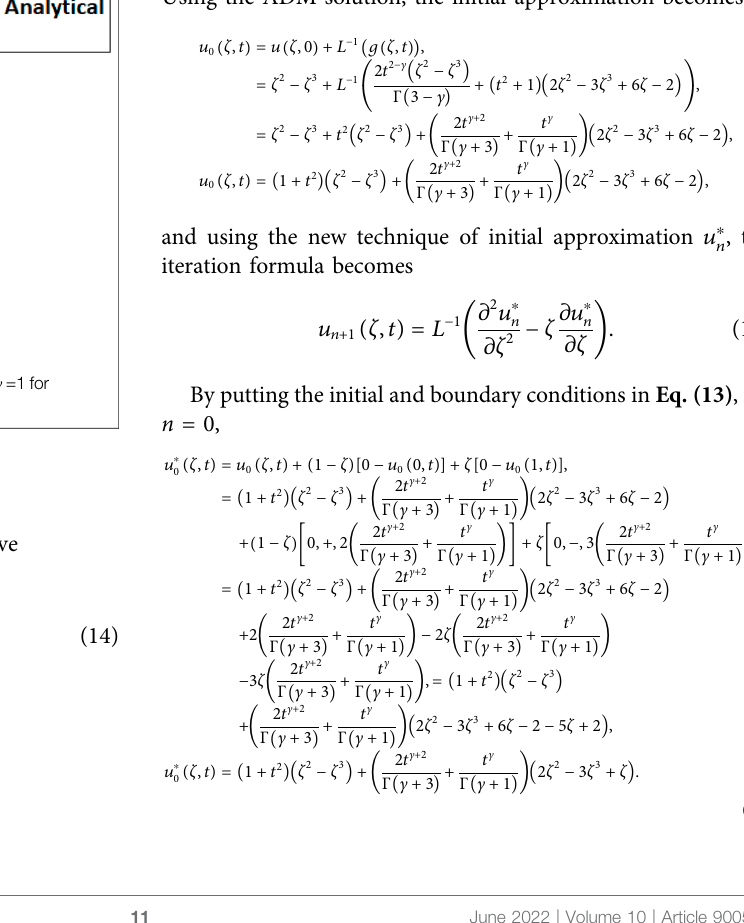
Frontiers in Physics |